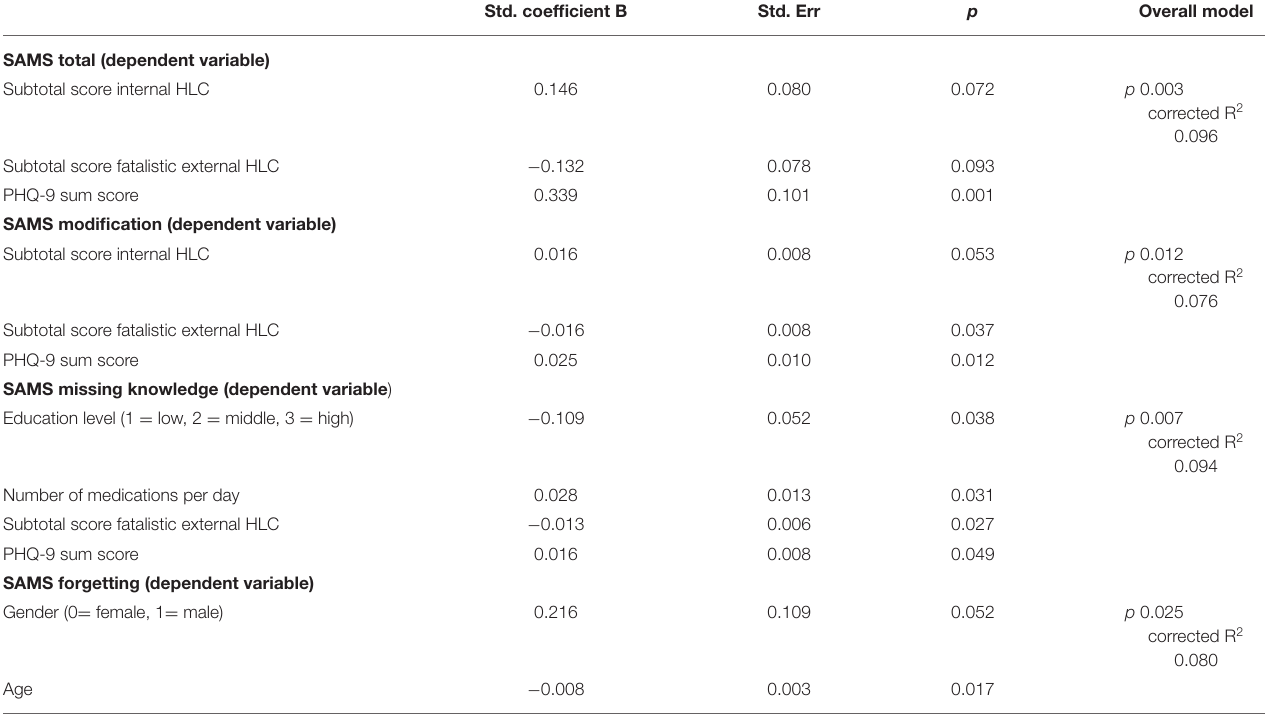
TABLE 4 | Summary of multiple linear regressions (final models after backward